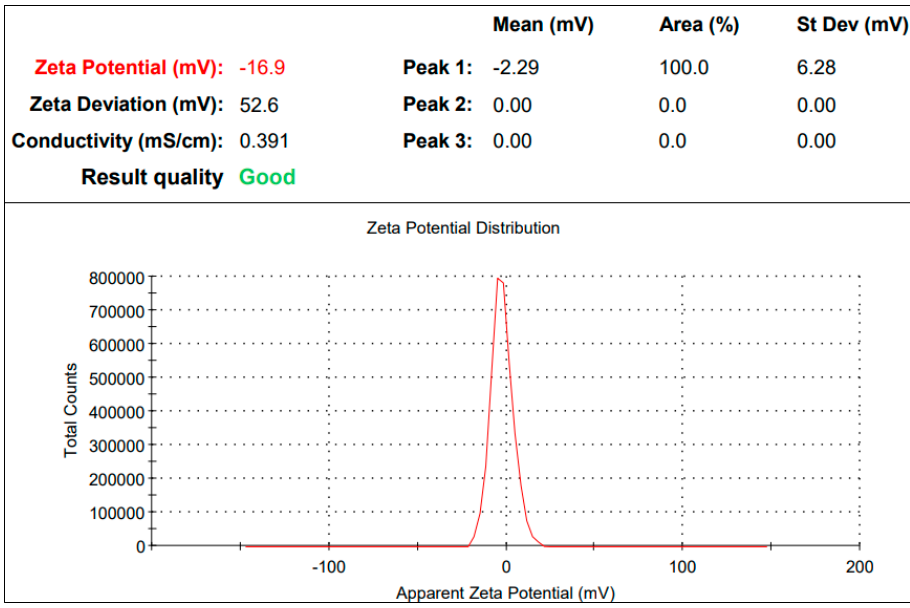
Figure 3. DLS analysis. The size of synthesized NPs is 59 nm.